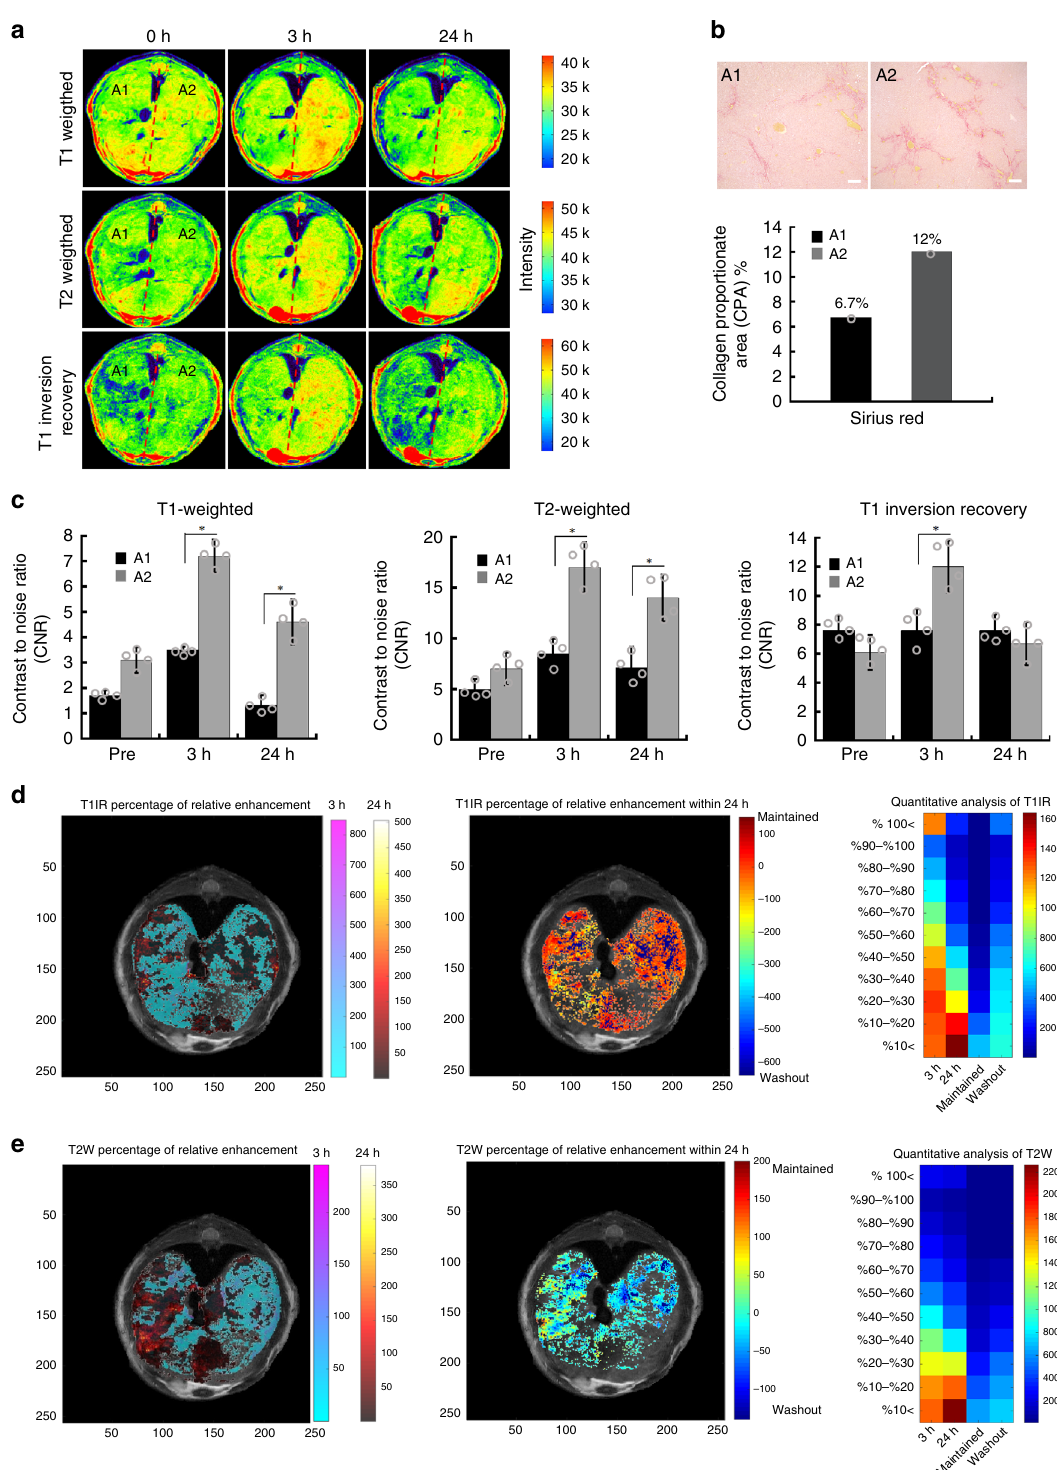
Fig. 5 Demonstration of time-dependent mapping of collagen heterogeneity in DEN model. a T1-, T2-weighted, and T1-inversion recovery images of DEN- induced diseased liver before and 3 and 24 h post injection of ProCA32.collagen1 demonstrating collagen heterogeneity of liver in Area 2 (A2). b Sirius red staining and CPA analysis con fi rmed that A2 has more collagen than A1 which correlates with MRI (scale bar, 100 µ m). c T1-, T2-weighted, and T1- inversion recovery images all demonstrated a higher contrast to noise ratio (CNR) in A2 of liver 3 h after ProCA32.collagen1 injection compared to A1. Data are represented as mean ± SD, n = 4 independent images. d Percentage of relative enhancement and quantitative voxel analysis of T1-inversion recovery images demonstrating liver regions enhanced at 3 and 24 h after injection of ProCA32.collagen1 compared to pre-injection (color scale represents number of voxels). e Percentage of relative enhancement and quantitative voxel analysis of T2-weighted images of liver demonstrating regions enhanced at 3 and 24 h after injection of ProCA32.collagen1 compared to pre-injection (color scale represents number of